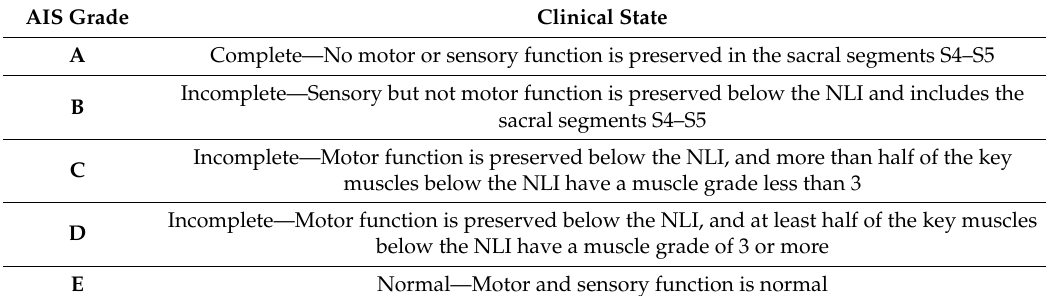
Table 2. The American Spinal Injury Association Impairment Scale (AIS). AIS grades from A–E considering the completeness of paralysis and the motor and sensory function